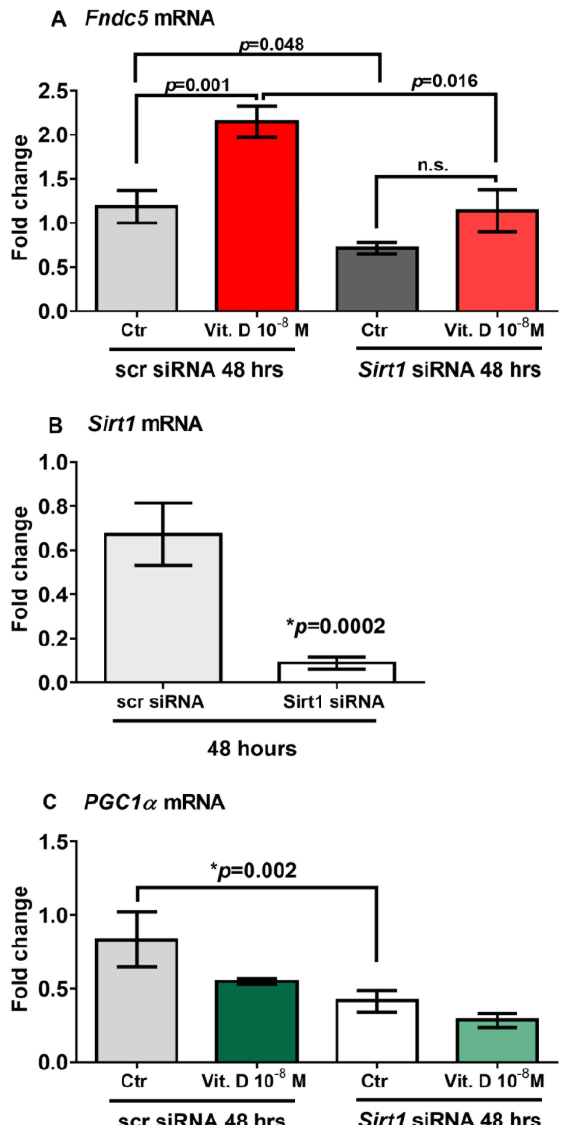
Figure 4. Forty-eight hours of treatment with 10 − 8 M 1 α ,25-dihydroxyvitamin D3 (vitamin D) fails to increase Fndc5 mRNA in Sirt1 -silenced myoblasts (Sirt1 siRNA) ( A ). Sirt1 mRNA expressions